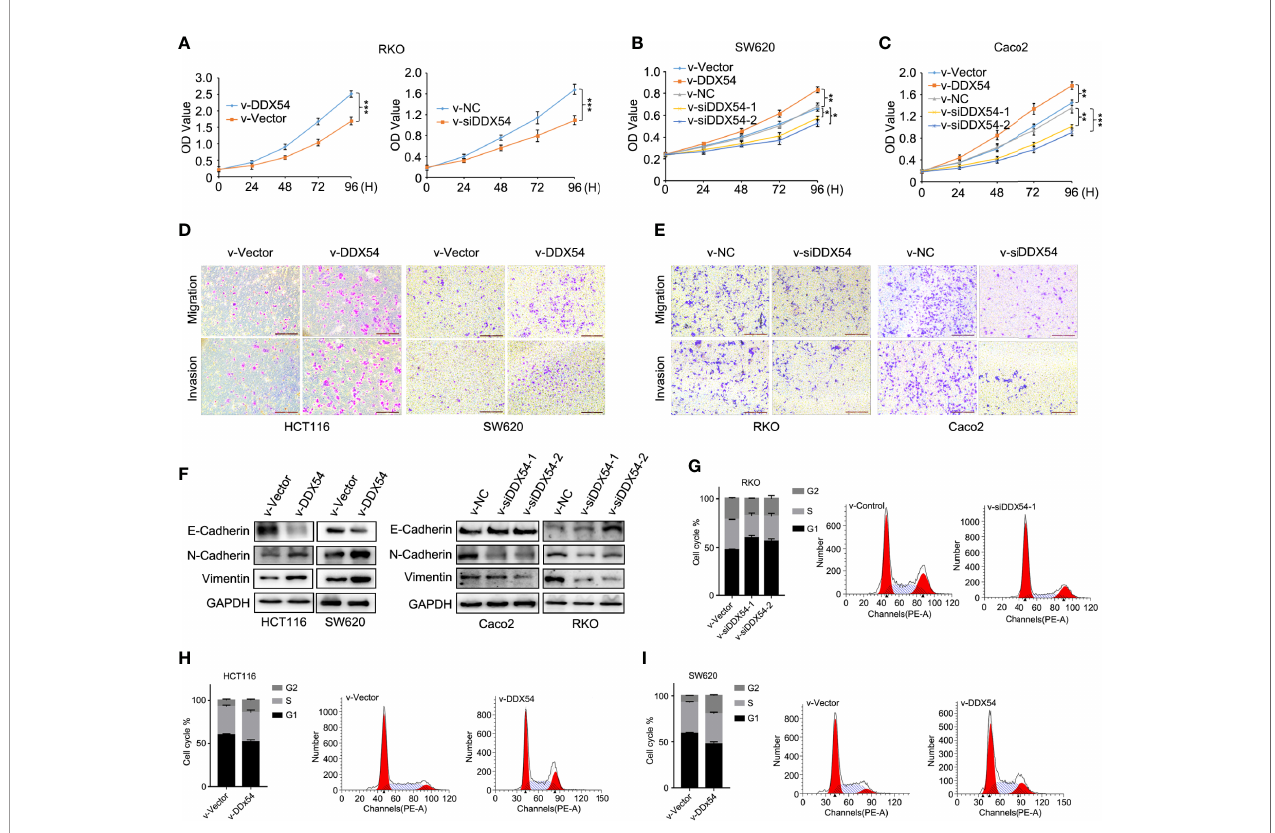
FIGURE 4 | DDX54 had a role on CRC cells. (A) The proliferative effects of DDX54 were examined through CCK8 assay in RKO stable cells, ***P < 0.001. (B) The role of DDX54 on proliferation was detected in SW620 cells, *P < 0.05, **P < 0.01. (C) DDX54 promoted the proliferation in Caco2 cells, **P < 0.01, ***P < 0.001. (D) The migration and invasion ability of HCT116 and SW620 was promoted by DDX54. (E) DDX54 knockdown attenuated the metastatic ability of RKO and Caco2. (F) EMT markers were determined by WB in CRC cells with DDX54 overexpression or knockdown. (G – I) DDX54 promoted the cell cycle process in CRC